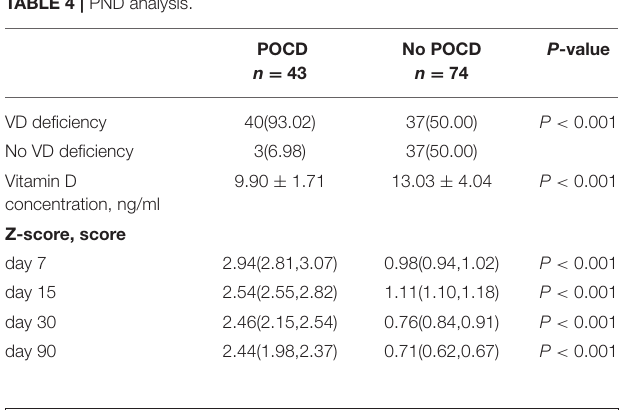
TABLE 4 | PND analysis.